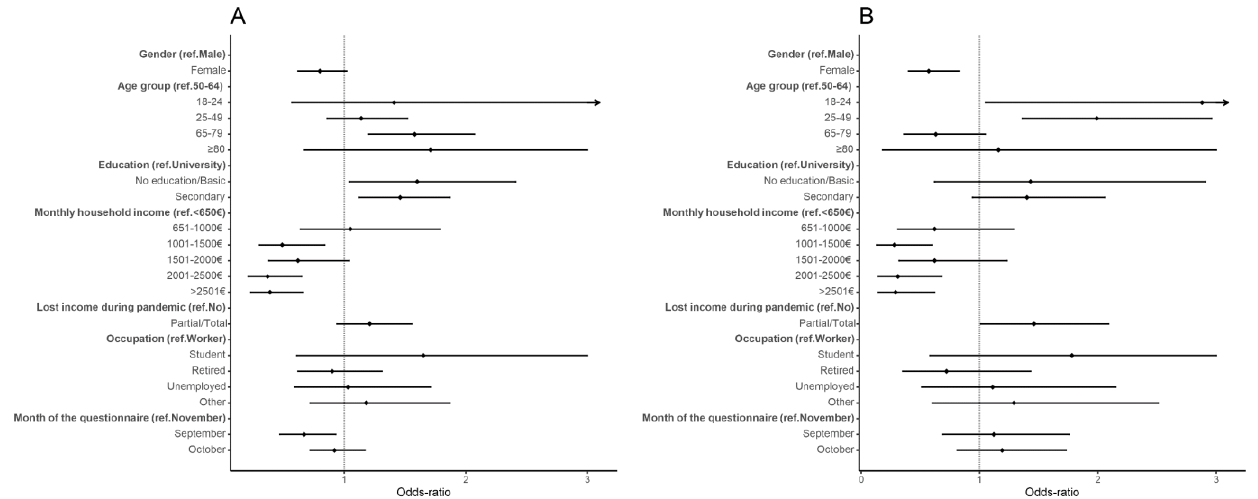
Figure 1. Forest plot of vaccine hesitancy for contextual influences. Adjusted odds ratio (adjusted for gender, age, education, and period of questionnaire) and the respective 95% confidence intervals are denoted by black dots and black lines, respectively. Forest plot confidence intervals were cut off at 3. ( A ) Results of the main analysis—vaccinated vs. hesitant (refuse, undecided and would take the vaccine); ( B ) results for the sensitivity analysis, removing individuals who would take the vaccine.